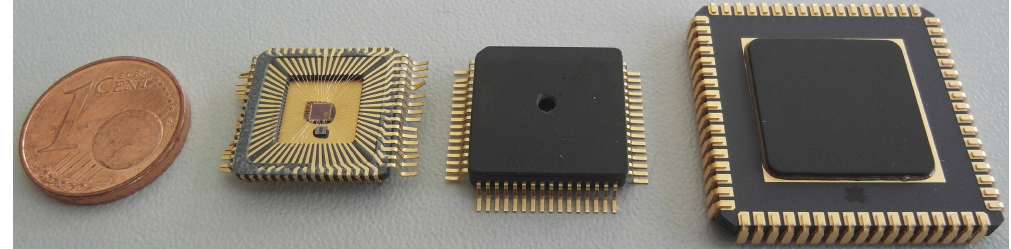
Figure 11. Chip size comparison. From left to right: one euro cent coin, real pressure sensor open package, real pressure sensor closed package, and on-chip dummy bridge ASIC